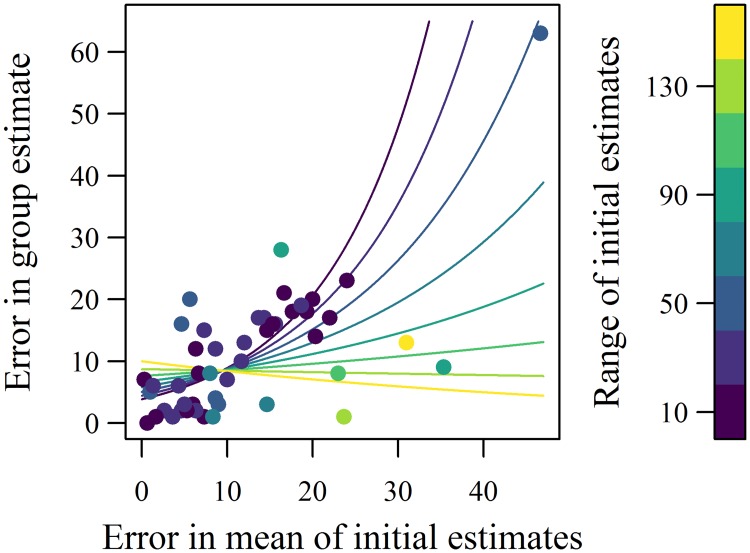
The effect of disagreement in initial individual estimates on improving group estimates in Experiment 1.Disagreement is measured as the range of initial estimates in each group. The colours represent this range, binned every twenty units. Coloured lines are fits for each range interval, calculated from the GLM coefficients which includes the significant interaction term between the error of the (arithmetic) mean and the range of the initial estimates. The main effects of gender and mean age are included in the calculation of fitted values, each fixed at their mean values in the data. If the error in the mean initial estimates directly determines the error in the group estimate, there should be a positive linear relationship between the two variables (as occurs with the darker points, i.e. groups with a smaller range of initial estimates). No relationship between the two errors (mean initial and group) can occur if the group discussion revises the estimate enough that the error of the mean initial estimates is no longer predictive of the error of the group estimate, as occurs with the more lightly coloured points.